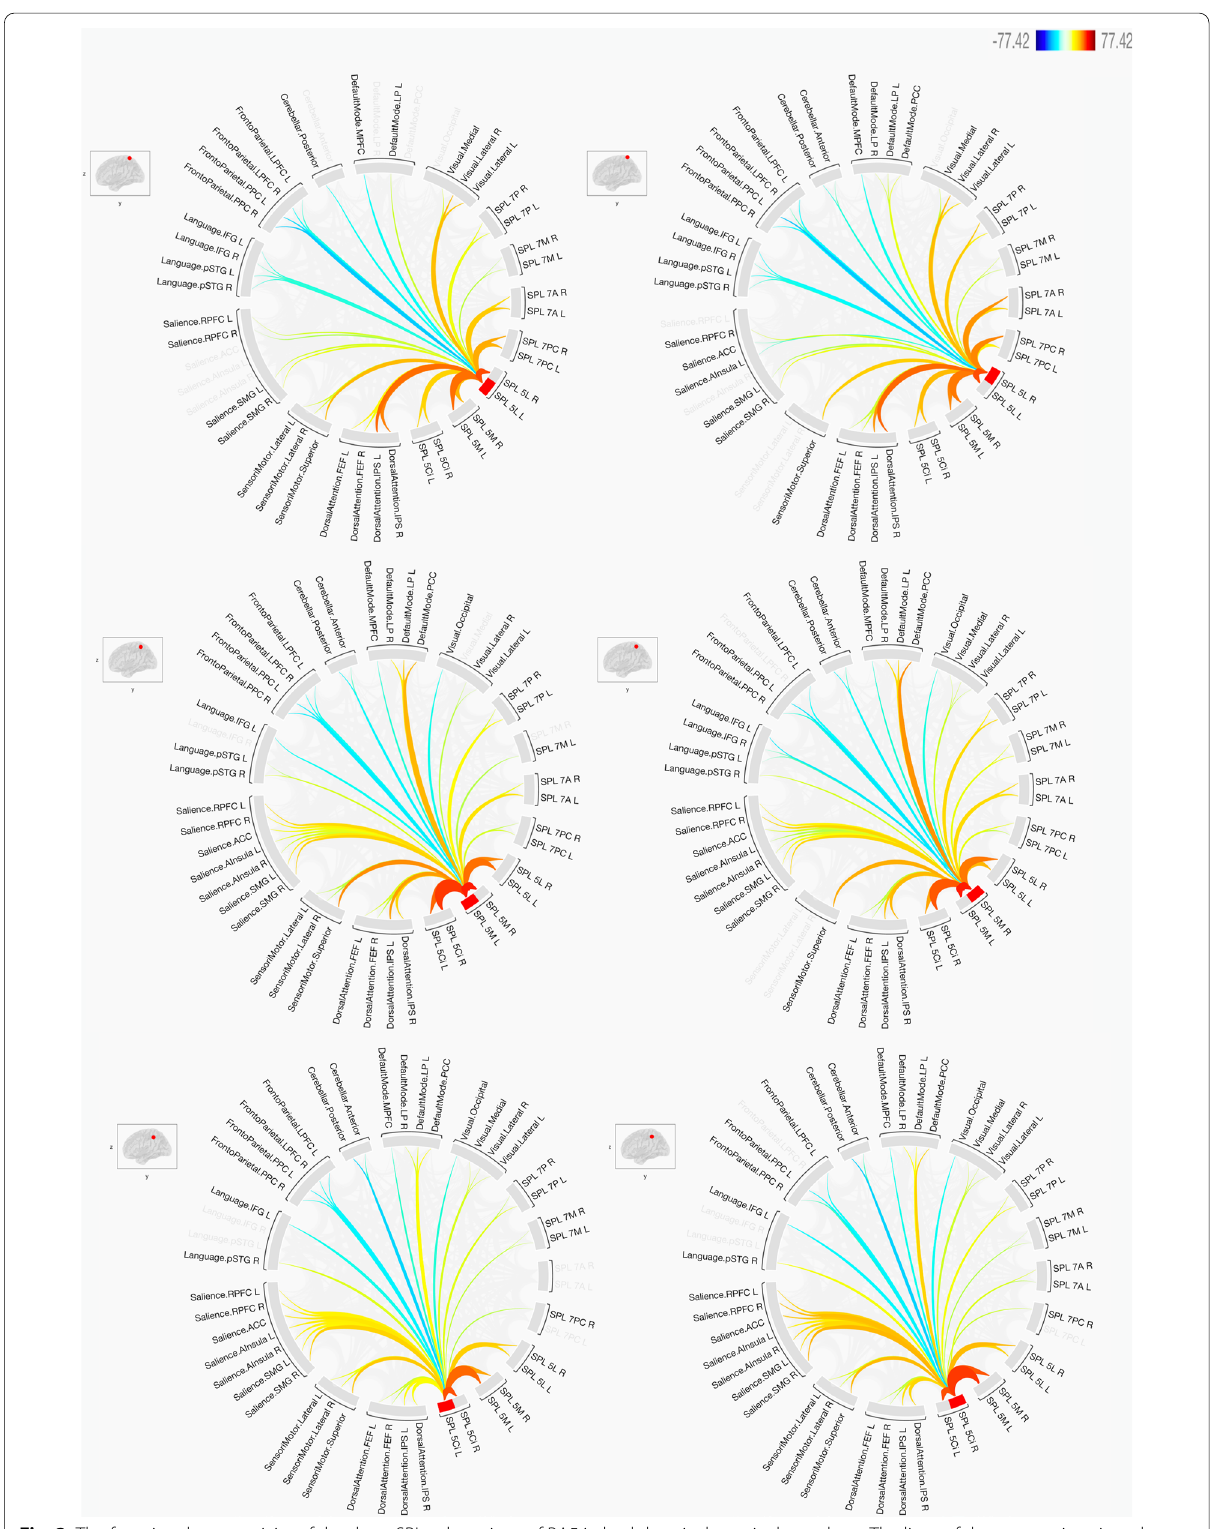
Fig. 3 The functional connectivity of the three SPL sub-regions of BA5 in both hemispheres is shown here. The lines of the connections in red indicate positive connectivity while blue indicates negative connectivity. The colours of the lines are proportional to statistical strength, and the T-bar is shown in the top right-hand